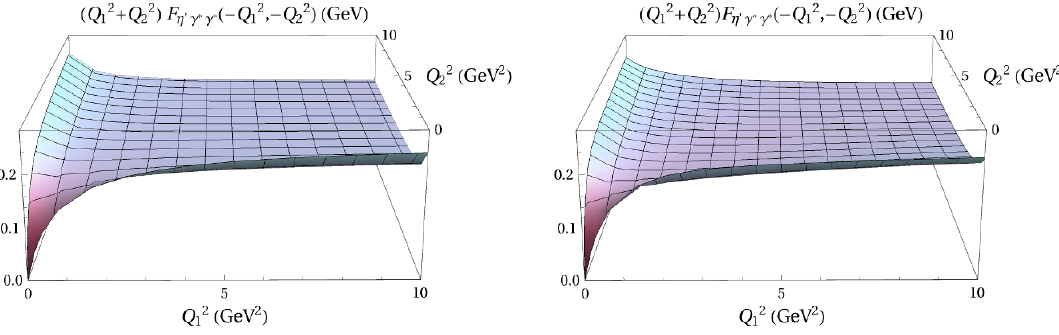
< 10 GeV 2 . The large- N c Regge ; Q 2 1 2